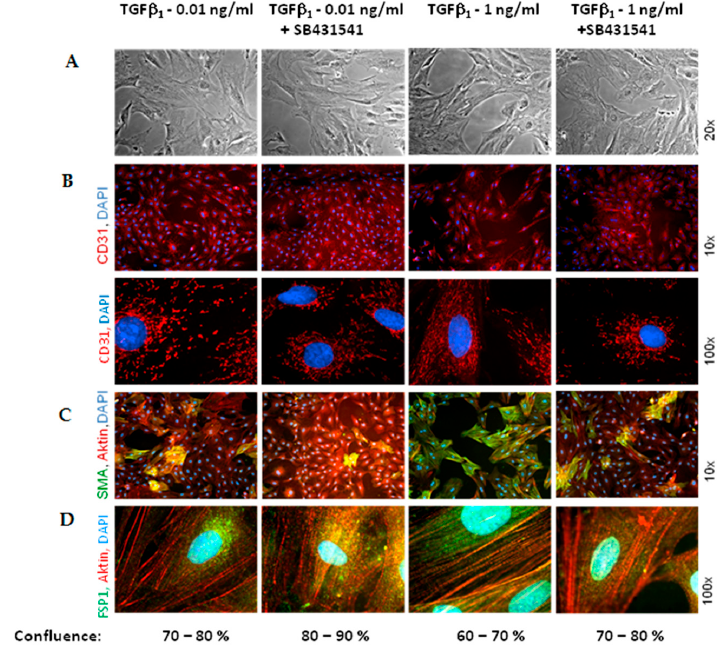
Figure 8. TGF β 1 promotes EndoMT via ALK5 receptor. MVECs were exposed to TGF β 1 for three days in presence or absence of the ALK5 inhibitor SB431542 (1 µM). ( A ) Phase contrast pictures. In these pictures confluence of the cell layer was determined. Additionally, immnuofluorescene was performed: ( B ) Double staining with CD31 antibodies (red) and nuclear DAPI-staining ( C ) Triplicate staining with α -SMA antibodies (green), actin staining with phalloidin (red), and nuclear DAPI staning (blue), ( D ) triplicate staining with FST1 antibodies (green), actin staining with phalloidin (red), and nuclear DAPI staining (blue).